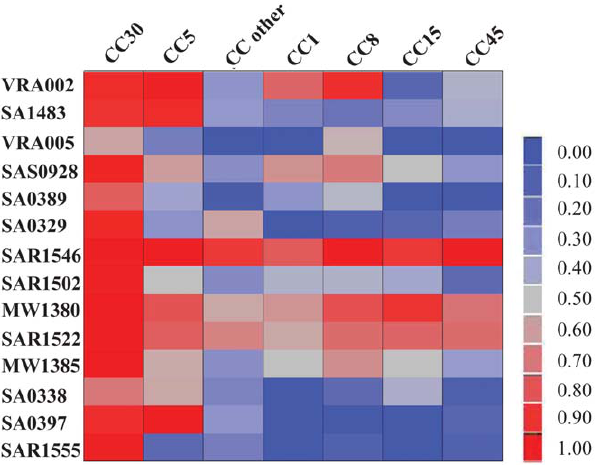
Figure 2. Distribution of 14 genes associated with complicated infections across clonal complexes. Proportion of isolates that have the 14 genes in each clonal complex shown on a color gradient with 1 being bright red and 0 being bright blue. All 14 genes are more abundant in CC5 and 30, the clonal complexes previously shown to exhibit a significant trend toward increasing levels of hematogenous complications. doi:10.1371/journal.pone.0018673.g002 PLoS ONE |